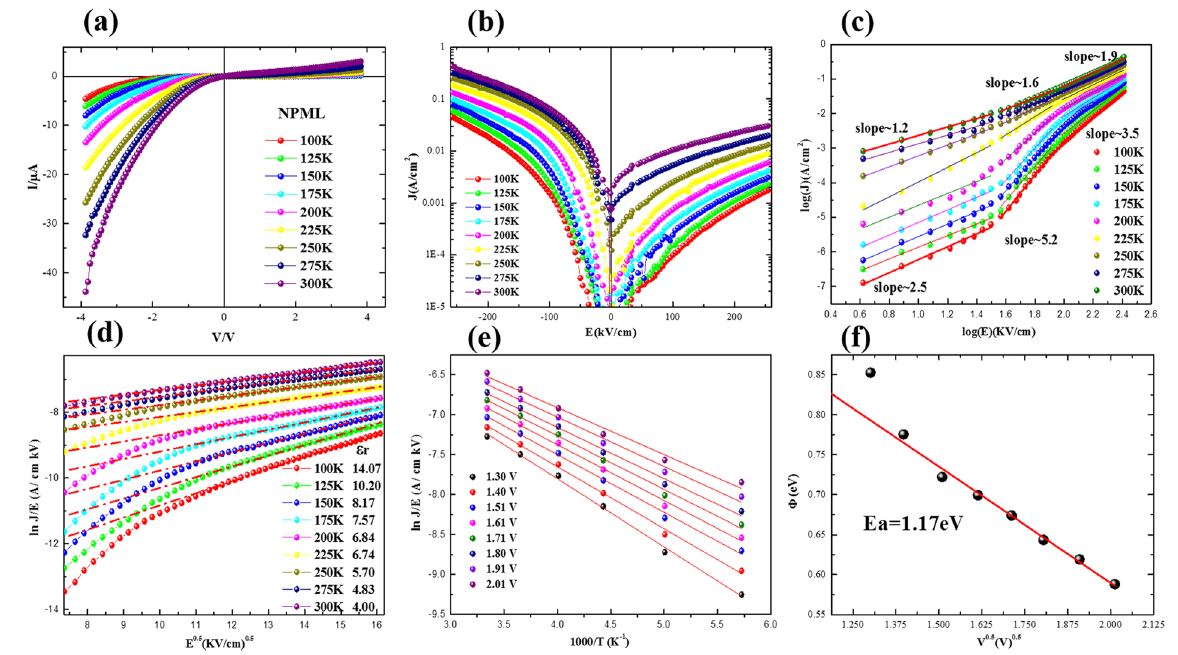
Figure 6. ( a ) Illustration of I-V measurements under different temperatures, ( b ) temperature and voltage dependence of J, ( c ) SCLC analysis at positive region, ( d ) ln(J/E) ~ E 1/2 at negative region, ( e ) temperature dependence of ln(J/E), and ( f ) relationships between activation energies and voltage for NPML heterostructures.